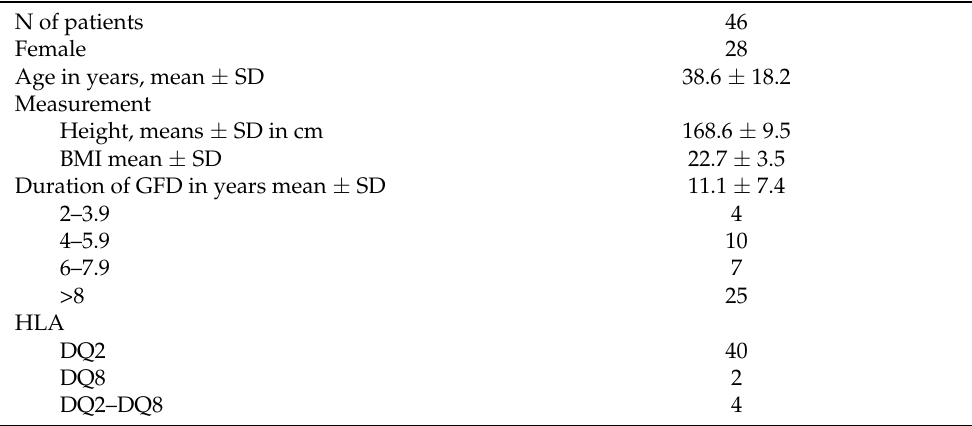
Table 1. Characteristics of randomized patients with celiac disease. Table 1 . Characteristics of randomized patients with celiac disease.